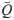
Effect of time delay between contractions of adjacent lymphangions in branching networks with nv = 4.(A) Pump function curves for synchronized pumping (Δtg = Δtv = 0 s), time delay only at the junctions (Δtv = 0, Δtg = 0.5 s), and the baseline case (Δtg = Δtv = 0.5 s) at pa − pe = 4 cmH2O (solid lines) and pa − pe = 3 cmH2O (dashed). (B) Q¯ vs. Δtv (Δtg = Δtv): effect of transmural pressure via (variation of pe) at ΔP = 3 cmH2O. Solid line: forward propagating contraction wave, dashed line: reverse propagating contraction wave.